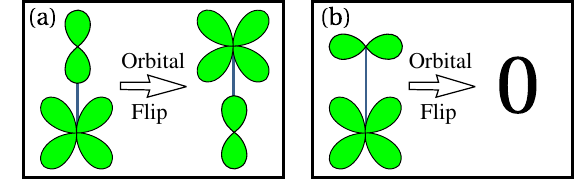
FIG. 7. Schematic view of the two types of orbital bonds found in the 4 d host: (a) an active bond with respect to orbital flips γ þ τ γ − ð τ þ H : c : Þ and (b) an inactive bond where orbital fluctua- i j tions are blocked by the orbital symmetry — here, the orbitals are static and only Ising terms contribute to the ground-state